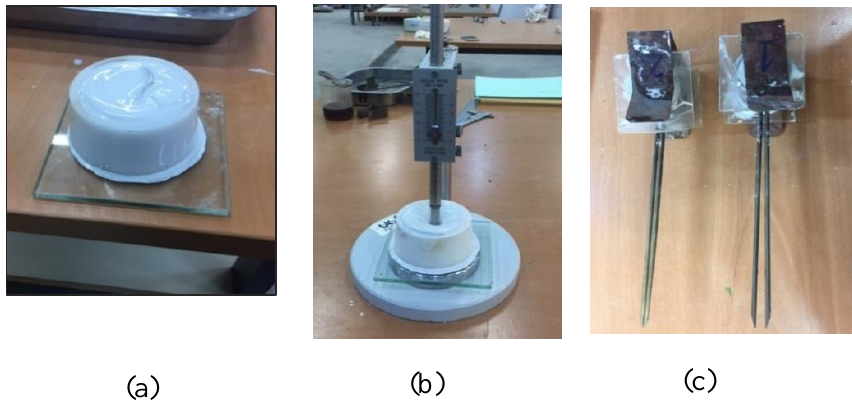
Figure 9. ( a ) GGBS-based paste. ( b ) Consistency. Vicat apparatus. ( c ) Le Chatelier molds.